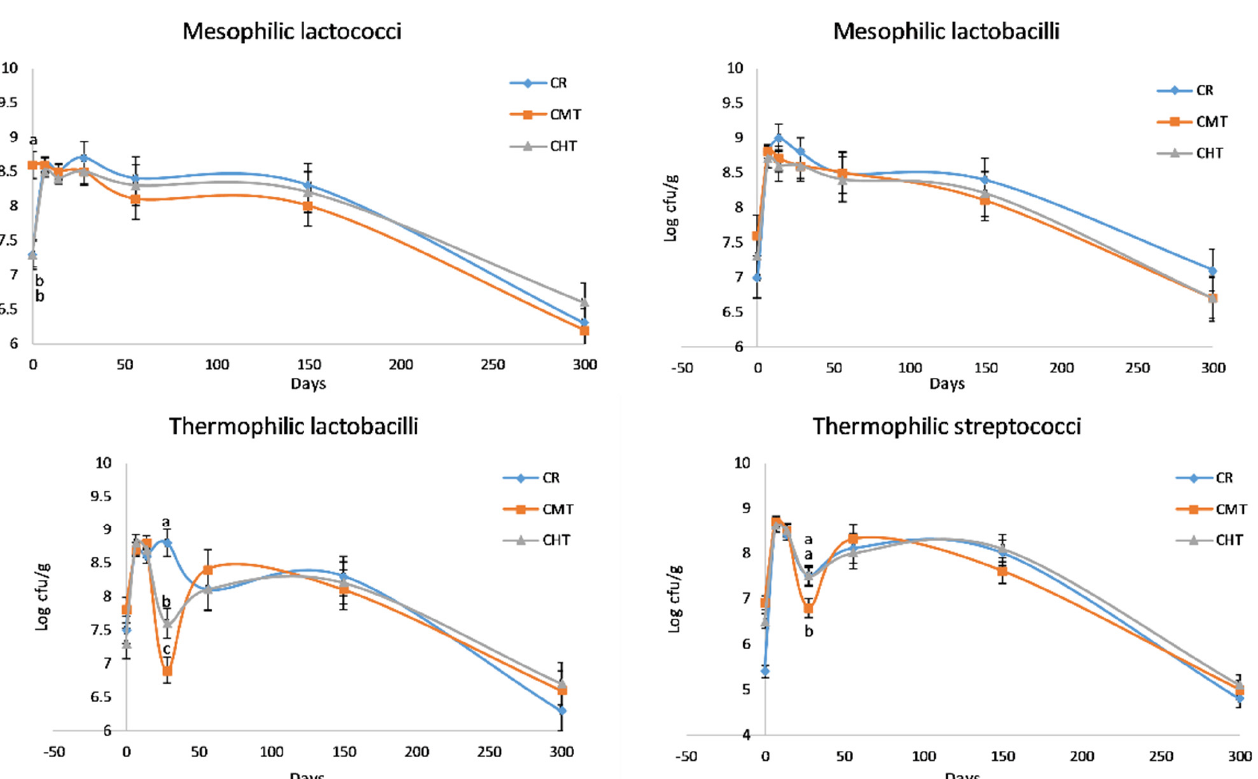
Figure 5. Counts of the non- lactic acid bacteria groups (cfu/g) in Canestrato Pugliese cheeses made from raw (CR), mild-thermized (CMT) and high-thermized (CHT) milk during ripening (0–300 days). Mean values of two analyses on two cheese wheels for each type of cheese.